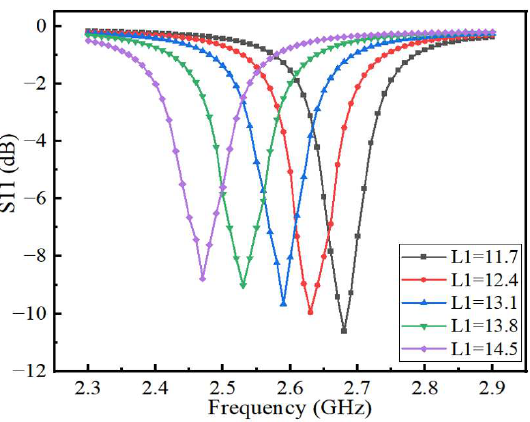
Figure 5. The effect of L1 on the resonant frequency at 2.68 GHz.